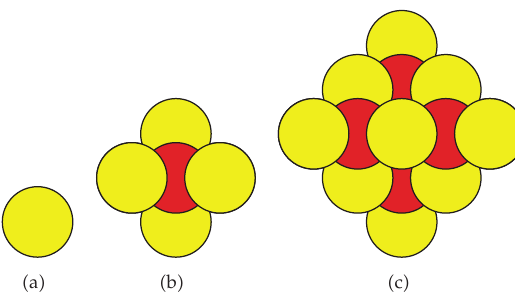
Figure 3: Finite pyramids with m (cid:7) 1 , 2 , 3 stones in the top row (cid:4) resp., (cid:4) a (cid:5) , (cid:4) b (cid:5) , and (cid:4) c (cid:5)(cid:5) , whose generating (cid:10) (cid:4) note that (cid:10) Z pyramid (cid:7) 1 corresponds to an empty pyramid corresponding to functions are given by Z pyramid m (cid:9) 1 1 the pure D6-brane (cid:5)